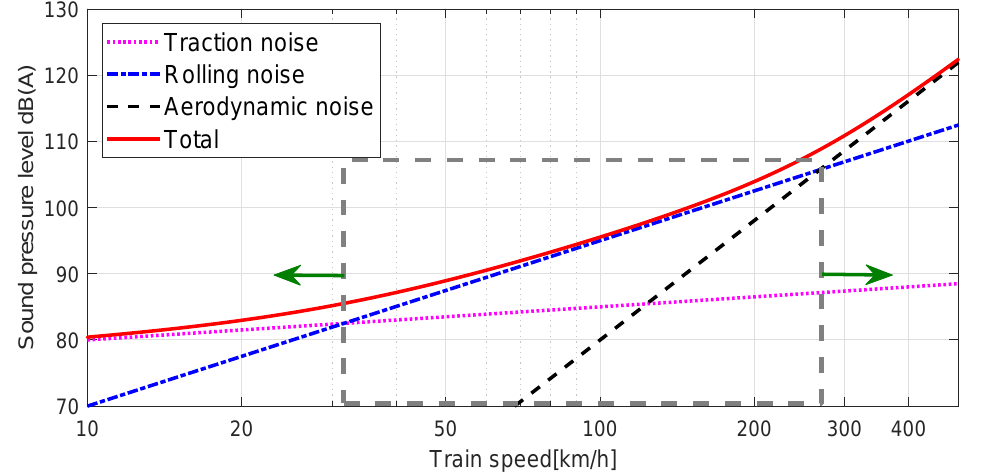
Figure 2. Sound pressure level by train